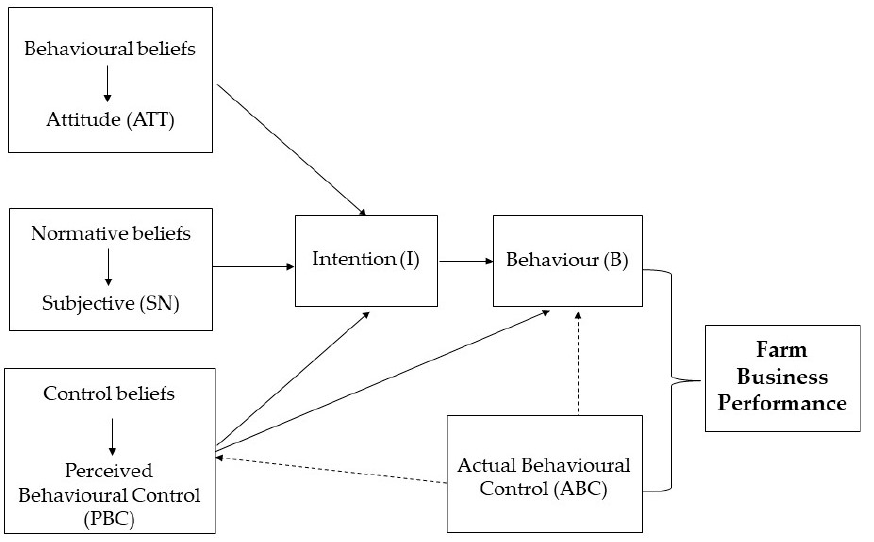
Figure 1. The theory of planned behaviour (Source: Authors’ construct adapted from